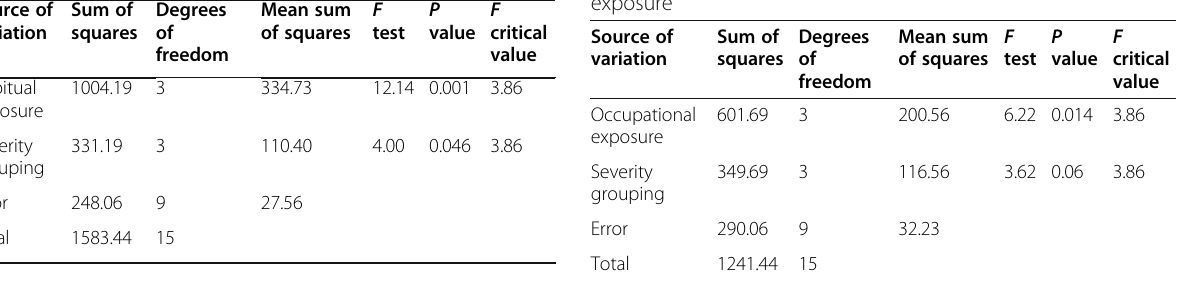
Table 14 ANOVA two-way classification of